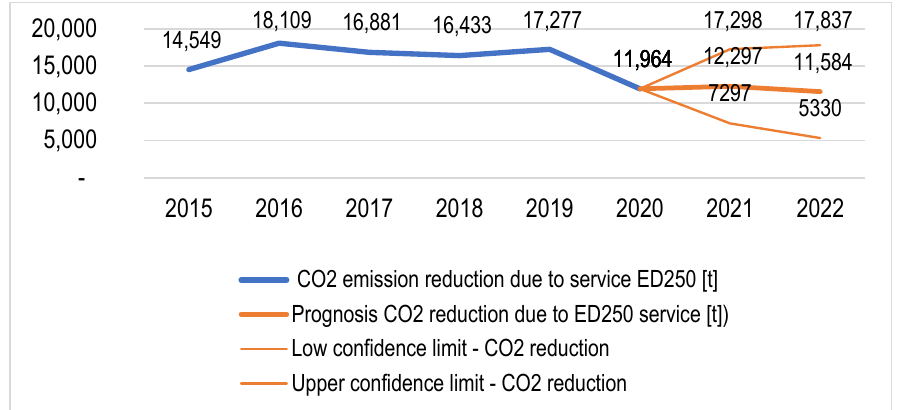
Figure 16. CO 2 emission reduction (2015 – 2020) and forecast. Source: developed by the authors.